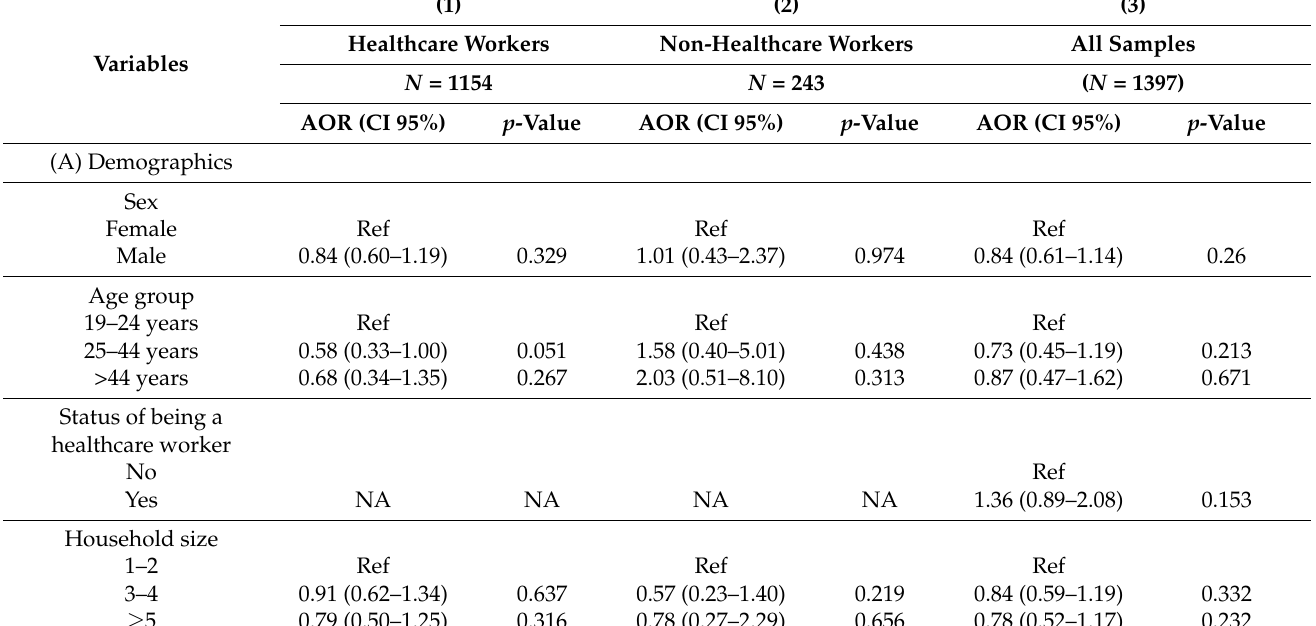
Table 3. Unadjusted and adjusted odds ratios of factors associated with experiencing at least one of COVID-19’s main symptoms.